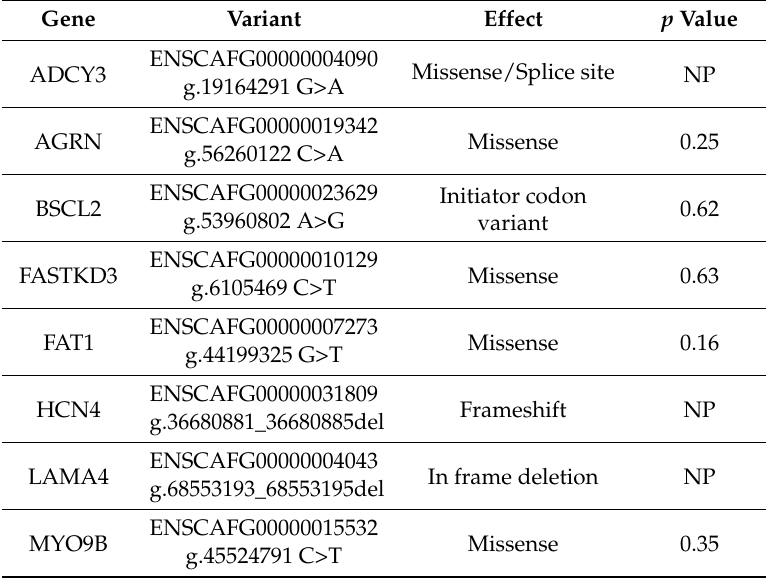
Table 1. Variants evaluated by Sanger sequencing. Gene, variant location, effect and statistical association by Fisher’s exact test are